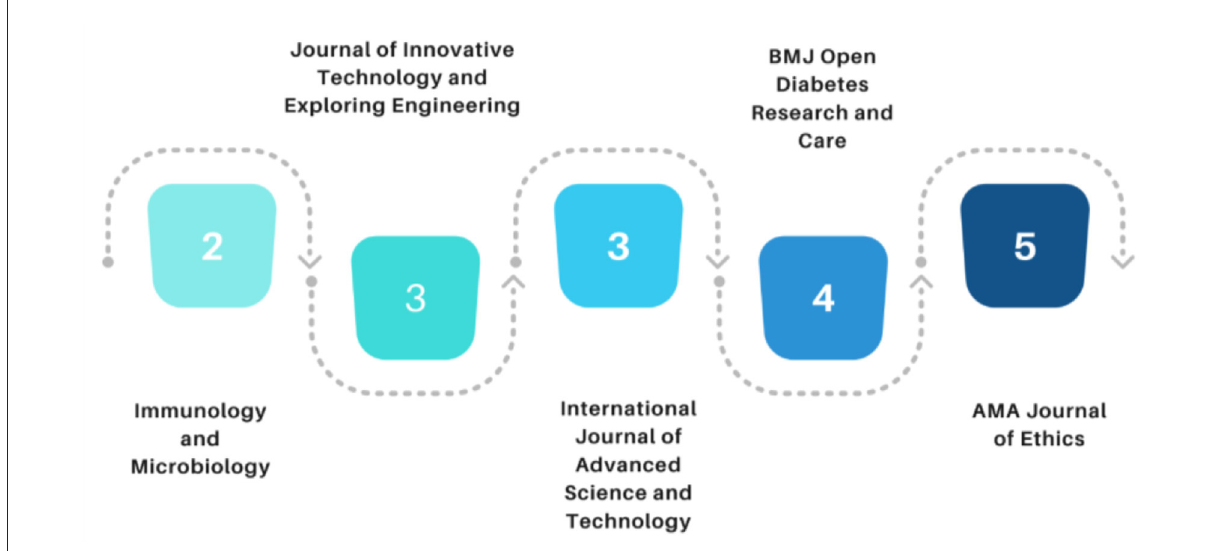
FIGURE3 Journals with the most frequent publication in digital technology in